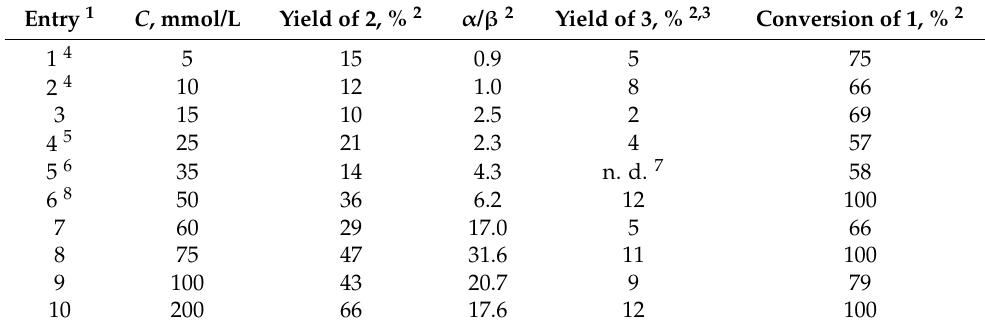
Table 1. Results of PTC glycosylation of CPP-OH by N -acetylsialyl chloride 1 under flow conditions at various